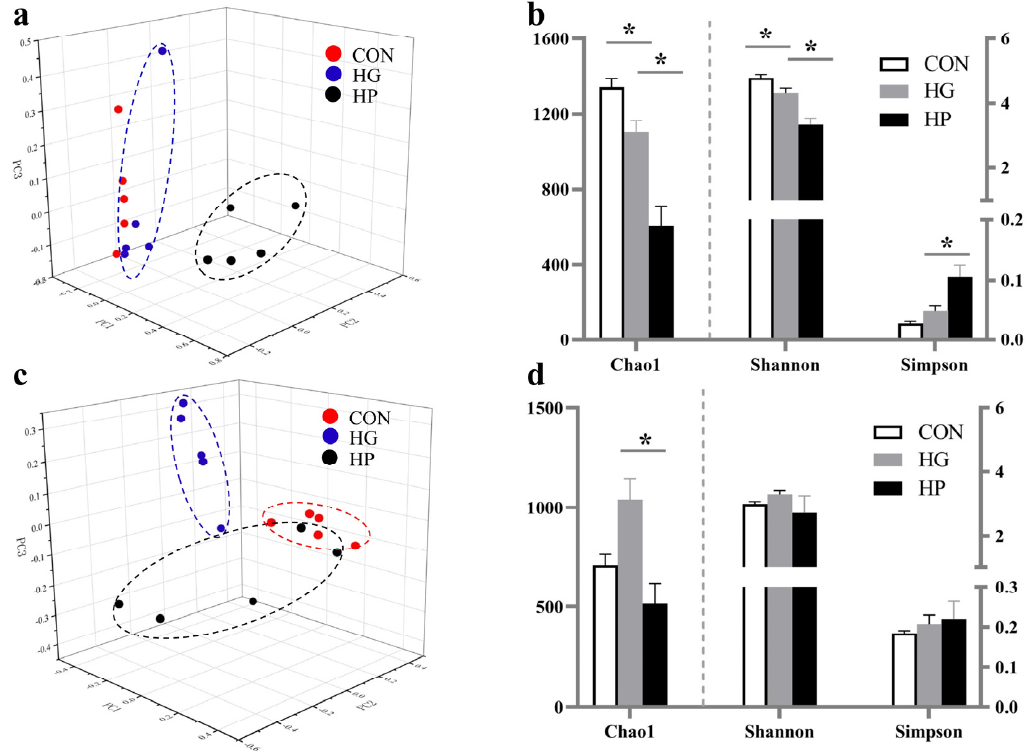
Figure 2. The alterations in the microbial diversity and richness of jejunal digesta and mucosa in Hu sheep (n = 5) fed the CON, HG and HP diets. The principal coordinate analysis (PCoA) of the jejunal digesta − ( a ) and mucosa − ( c ) associated microbiota. Summary overview of the Chao1, Shannon, and Simpson index in the jejunal digesta − ( b ) and mucosa − ( d ) associated microbiota. CON, the control group; HG, the high-grain group; HP, the pelleted high-grain group. * p <